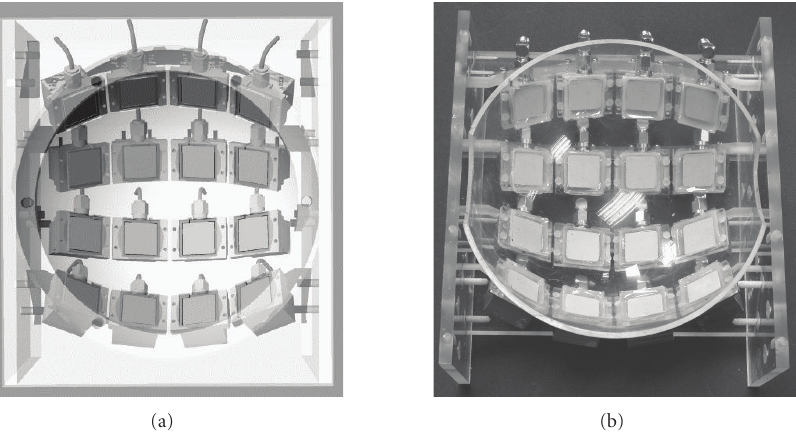
Figure 1: Symmetrical curved antenna array used in microwave radar for breast cancer detection: (a) CAD model, (b) photograph of the manufactured array. The array consists of sixteen UWB antennas populated on a section of